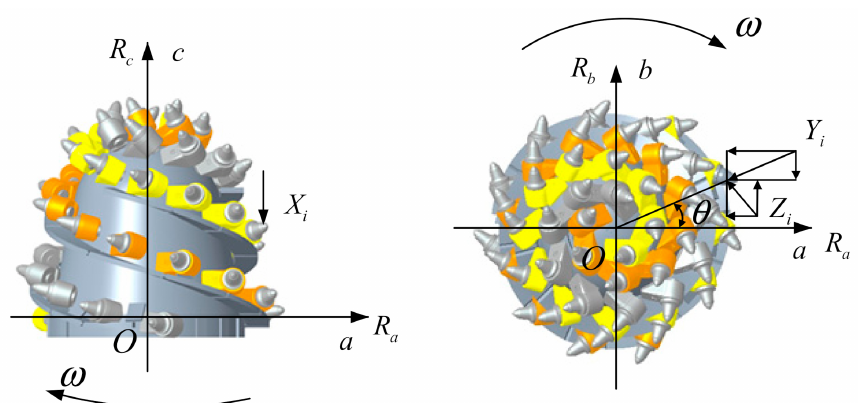
Figure 1. Force distribution of the pick and cutting head. Z i is the cutting resistance of the i -th pick; Y i is the traction resistance of the i -th pick; X i is the lateral resistance of the i -th pick; R a is the cutting lift force of cutting head; R b is the transverse resistance of cutting head; R c is the propulsion resistance of cutting